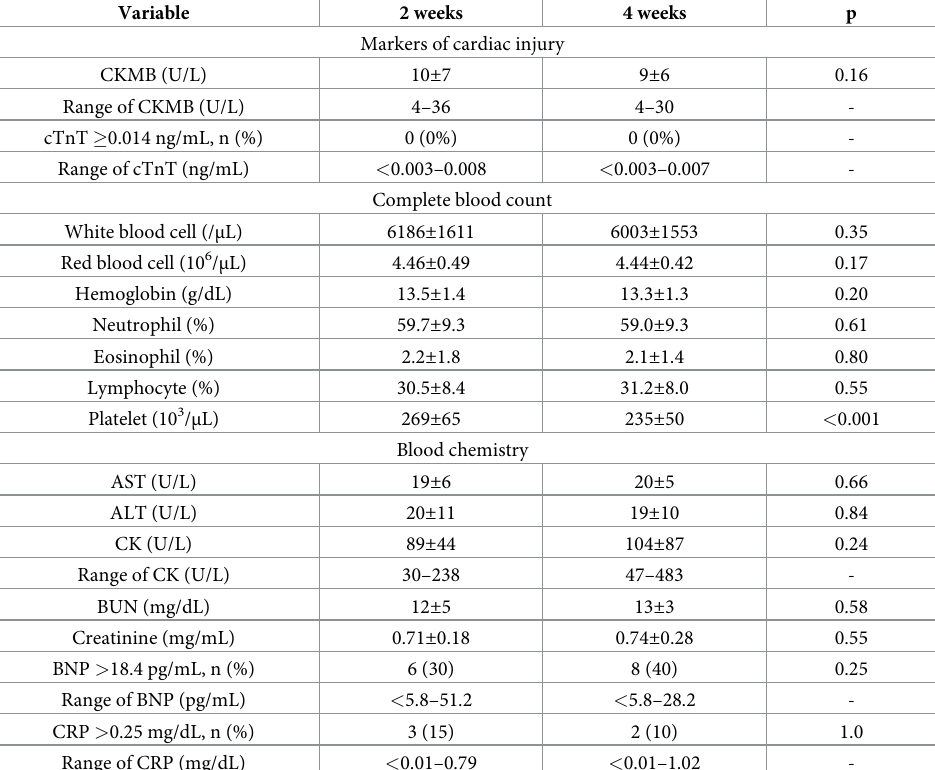
Table 4. Biological makers from blood sampling obtained at 2 and 4 weeks after diagnosis of